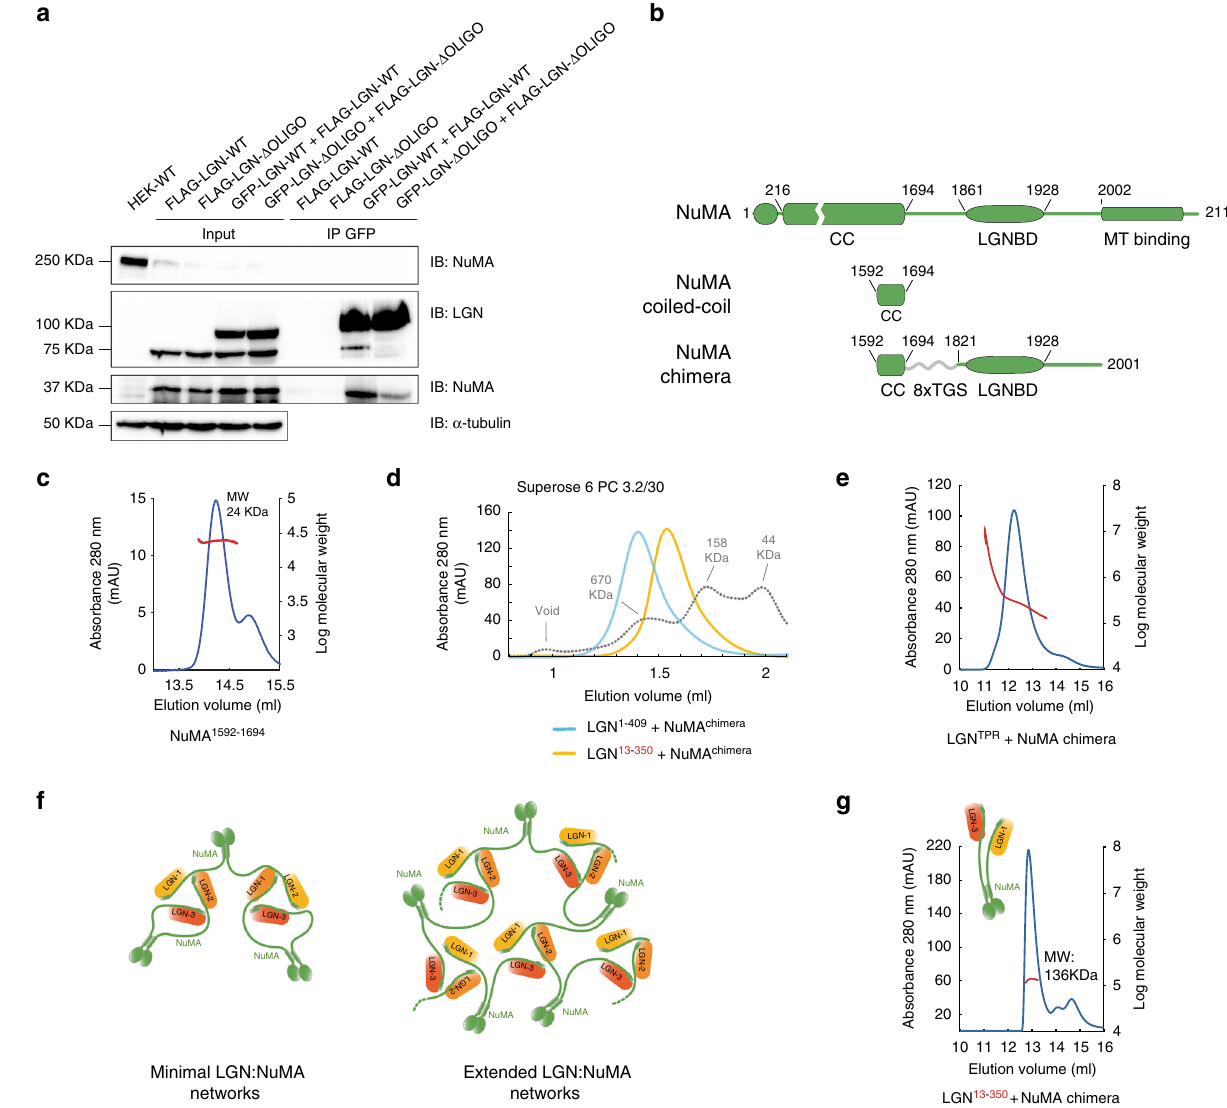
Fig. 4 Binding of dimeric NuMA to LGN TPR generates protein networks. a NuMA:LGN form hetero-hexamers in mitotic cells. HEK293T cells stably depleted of endogenous NuMA and stably expressing NuMA 1821 – 2115 were transiently co-transfected with plasmids expressing human GFP-LGN wild-type and LGN- 3xFLAG wild-type or GFP-LGN- Δ OLIGO and LGN- Δ OLIGO-3xFLAG. After 48 h, mitotic lysates were immunoprecipitated (IP) with anti-GFP antibodies conjugated to agarose beads, and immunoblotted with the indicated antibodies. Cells transfected with LGN-3xFLAG constructs were used as speci fi city control of the IP, and wild-type HEK293T cells were loaded to monitor NuMA depletion (IB anti-NuMA at a molecular weight of 250 kDa) and NuMA 1821 – 2115 expression (IB anti-NuMA at a molecular weight of 37 kDa). b Scheme of NuMA full-length, the C-terminal part of NuMA coiled-coil, and the NuMA chimera used to assemble NuMA:LGN TPR multimers in vitro. c SLS pro fi le of NuMA 1592 – 1694 showing an average molecular mass of 24 kDa along the peak, as expected for a dimeric construct. d SEC elution pro fi les of the NuMA chimeric construct encompassing the coiled-coil and the LGNBD in complex with LGN TPR (LGN 1 – 409 , blue trace) or LGN TPR- Δ OLIGO (LGN 13 – 350 , yellow trace). Complexes of NuMA-chimera with the oligomerization-de fi cient LGN TPR construct elute later indicating that they have an average molecular weight lower than the ones assembled with LGN TPR , as con fi rmed by the SLS analyses of Fig. 4e – g. The elution pro fi le of globular molecular weight markers is shown in gray dotted lines. e SLS pro fi le of the NuMA-chimera:LGN TPR sample indicating a polydispersed population of complexes with molecular masses in the range of 4.6 MDa to 130 kDa. f Scheme of different oligomers resulting from the assembly of NuMA with LGN TPR . The minimal stoichiometry of dimeric NuMA engaged in hetero-hexamers with LGN TPR is 6:6 (left). When each of the dimeric NuMA chains belongs to a different LGN TPR donut, higher order protein networks with diverse stoichiometry are possible (right). g SLS analysis of NuMA-chimera:LGN-TPR- Δ OLIGO showing that in the absence of NuMA:LGN oligomerization complexes with an average molecular mass of 136 kDa are formed, corresponding to 2:2 at the cortex by direct binding to G α i 9 . In this setting, we GFP-NuMA- Δ OLIGO-GoLoco did not rescue spindle engineered an oligomerization-de fi cient GFP-NuMA- misorientation in spite of accumulating at the cortex at the Δ OLIGO-GoLoco construct that localizes at the cortex but is same levels of the orientation-pro fi cient NuMA-GoLoco unable to form high-stoichiometry NuMA:LGN assemblies (Fig. 5b, c). This result indicates that it is not the presence, but (Fig. 5a). When probed in HeLa cells treated with MLN8237, the molecular organization of cortical NuMA in complex